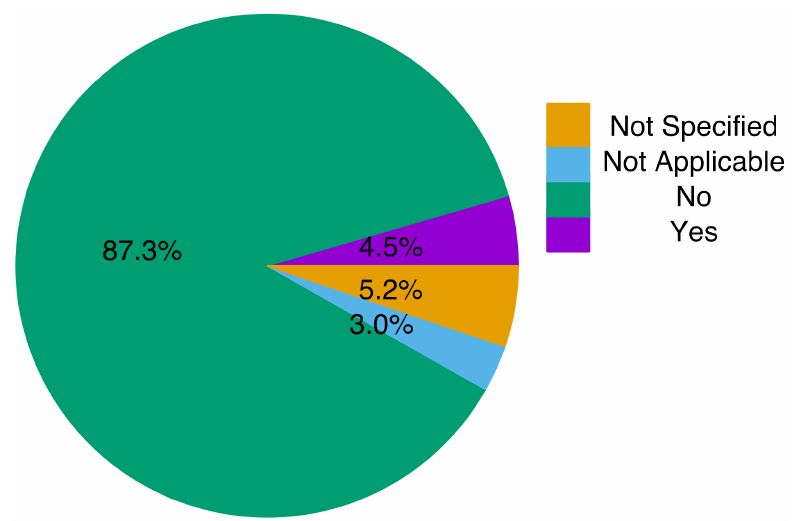
Figure 9. Dataset classification based on positive and negative case records.